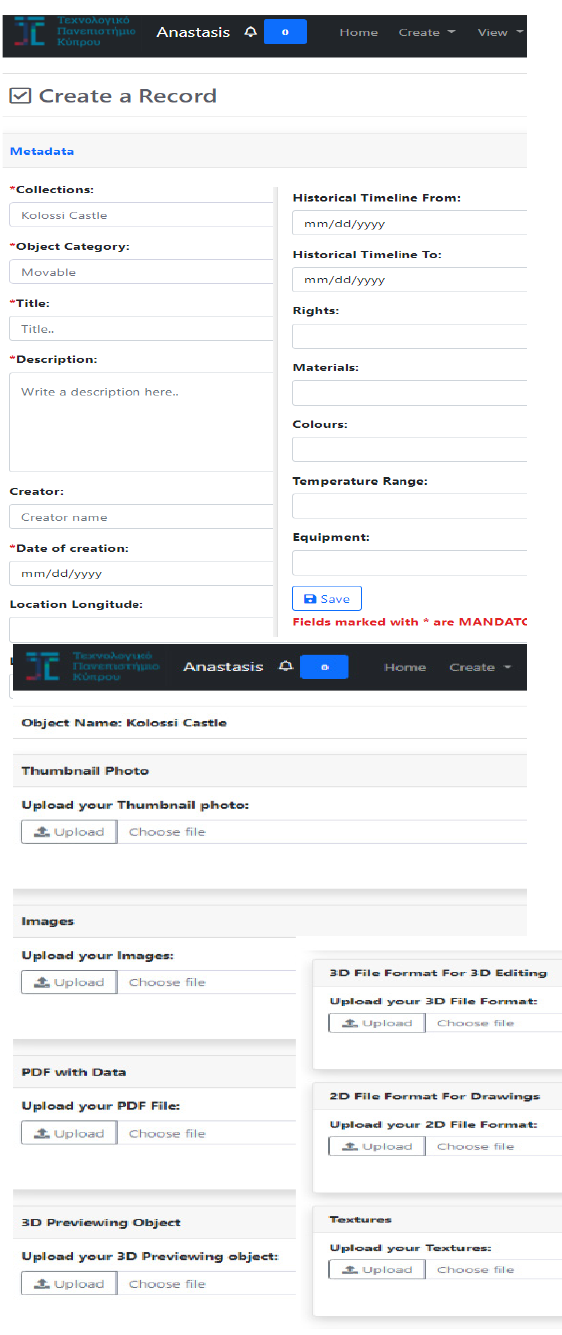
Figure 15. The setup of the annotations for the enrichment of metadata and the data that can be uploaded and